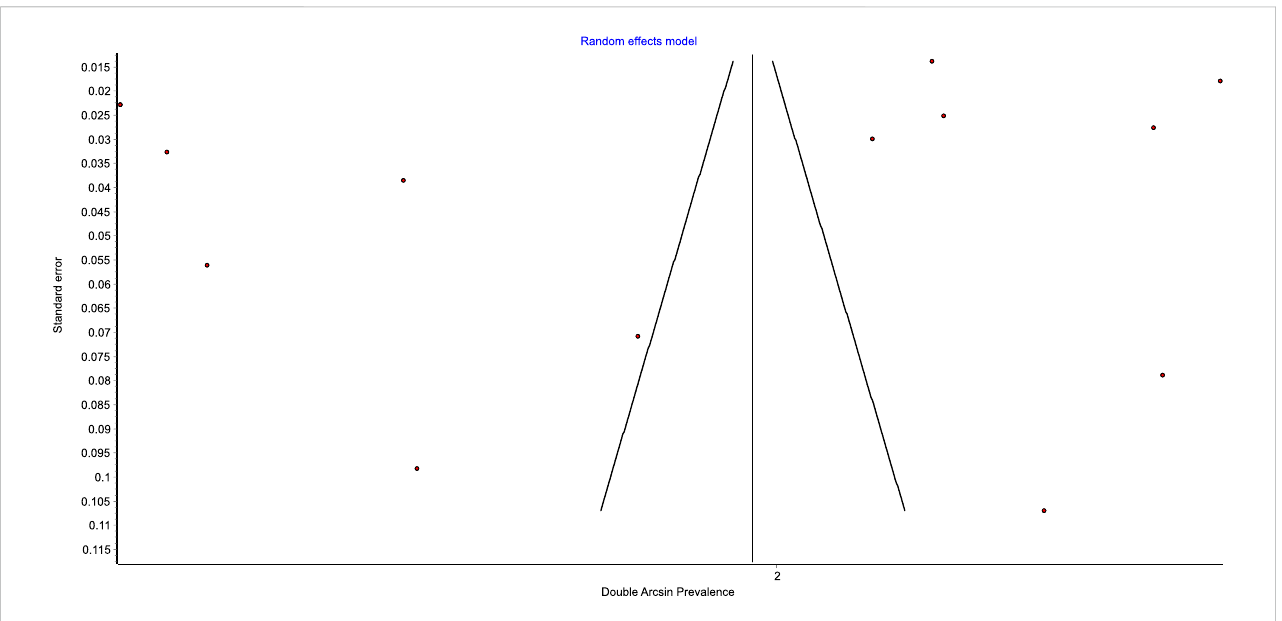
FIGURE 3 Funnel plot of the prevalence of polypharmacy among patient with